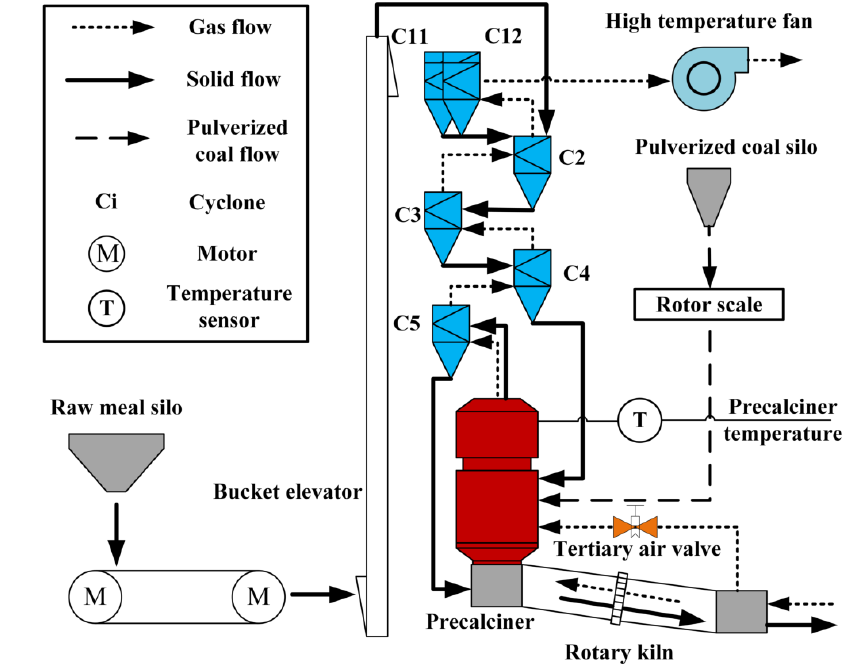
Figure 1. Cement calcinations